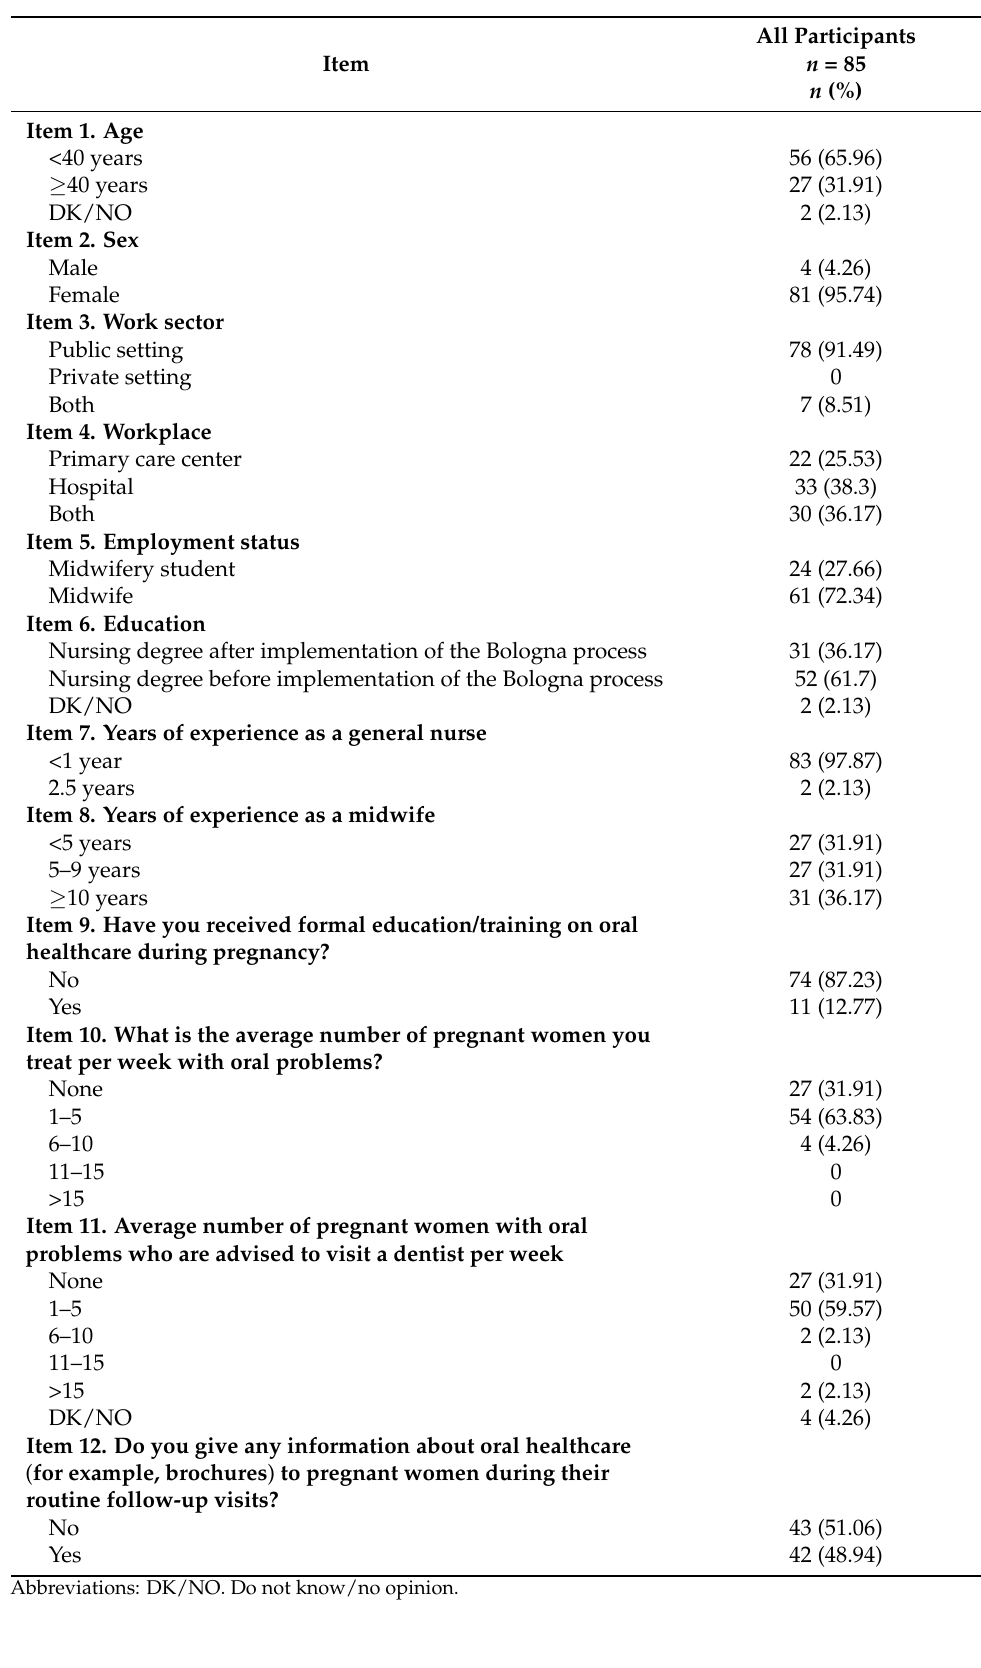
Table 1. Sociodemographic characteristics and other personal data of the study’s